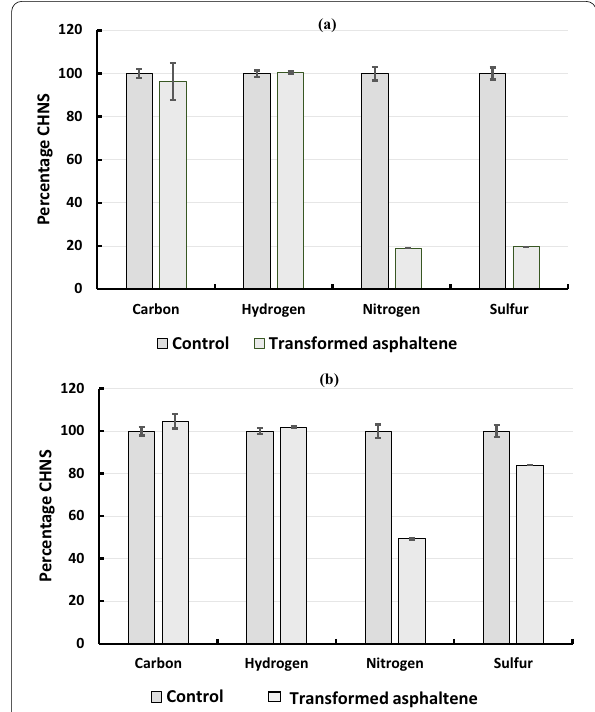
Fig. 2 Elemental analysis of untreated and biotransformed asphaltene. a Elemental changes in asphaltene due to biotransformation by growing consortium. b Elemental changes in asphaltene due to biotransformation by resting